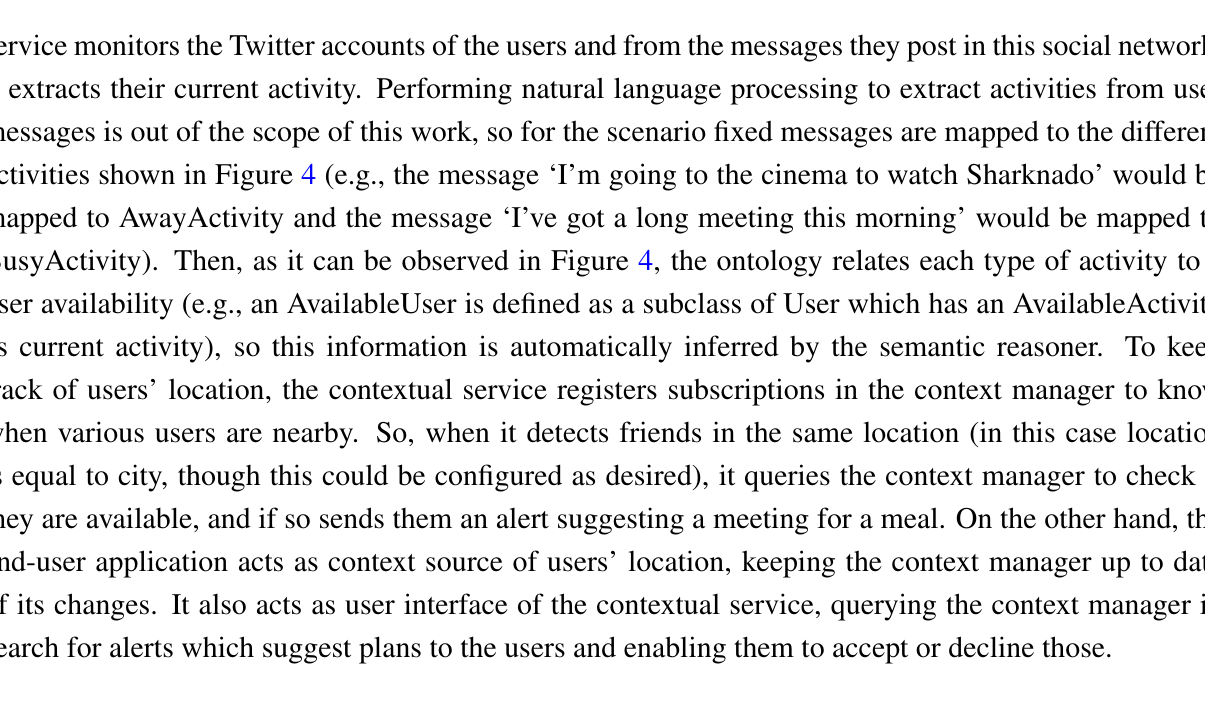
Prototypes of the Context Manager (a); Contextual service (b) and Mobile application